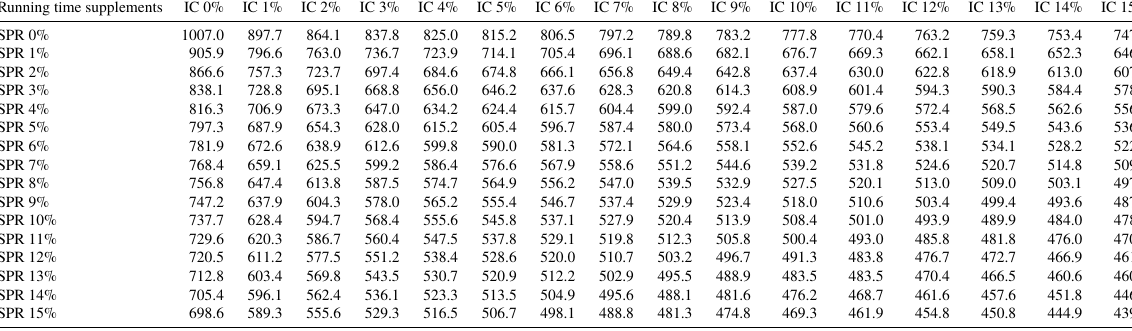
Table 14: Total traction energy consumption (kWh) per IC-SPR cycle for different running time supplements for the real-world case study